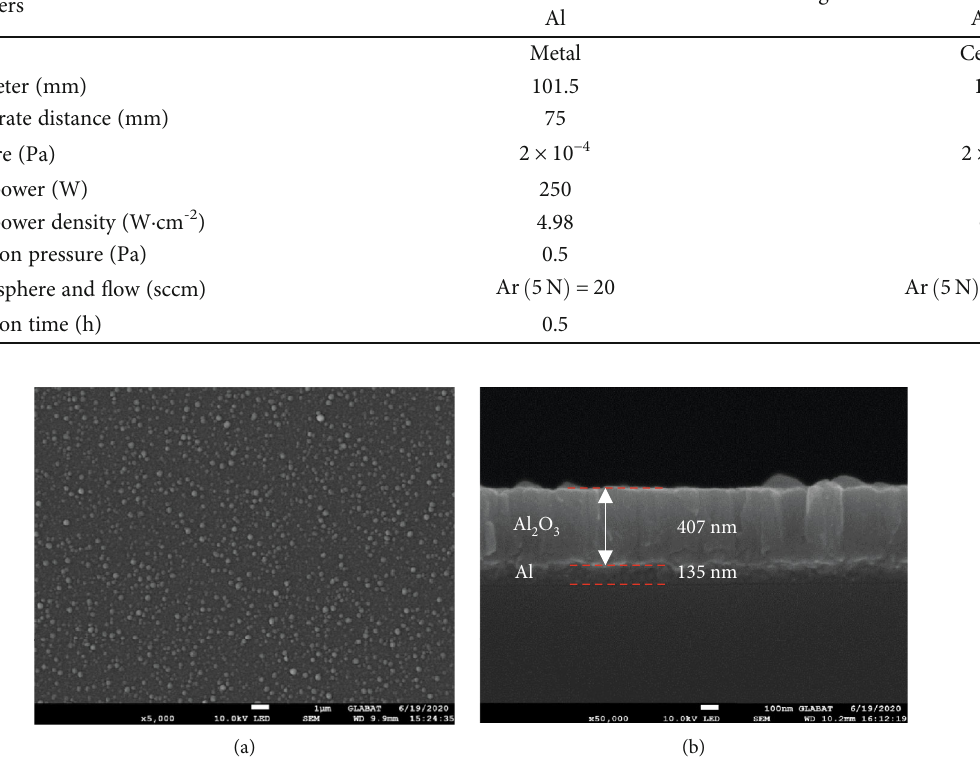
Figure 1: SEM images of the Al/Al